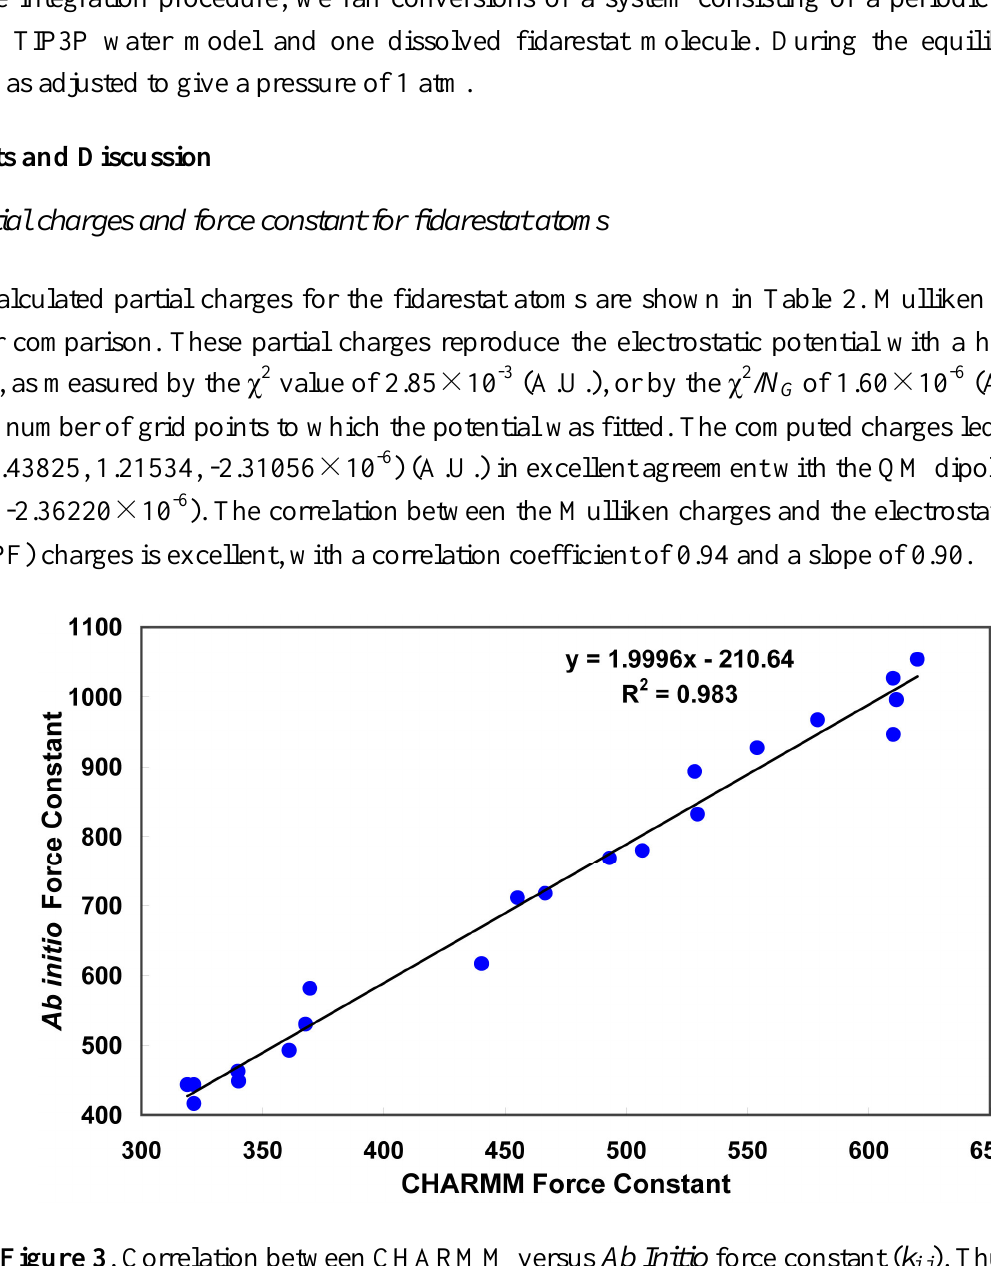
). Thus, i,j ,…, c are the 1 N